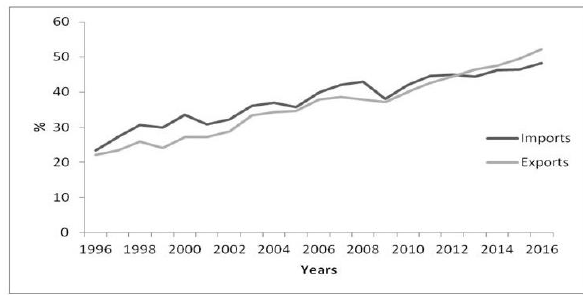
Fig. 1. GDP growth rate for Poland and the EU (annual %) (Source: Authors’ own elaboration based on data from World Bank, 2018b)